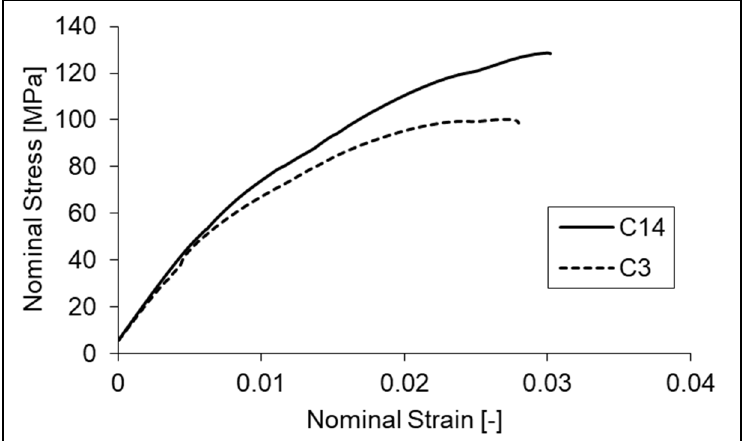
Figure 11. Representative nominal stress vs. nominal strain curves from tensile testing of 3D-printed specimens.